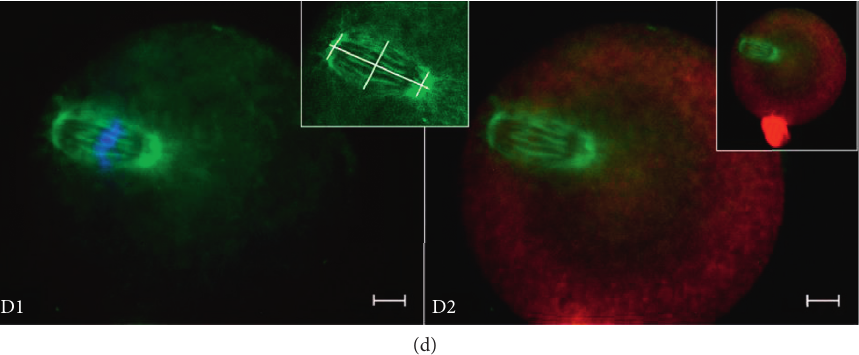
Figure 4: Fluorescent imaging of meiotic spindles (FITC-labelled tubulin), chromatin (stained by Hoechst 3325), and actin structures (Phalloidin-TRITC) in control and CIOA oocytes. Original magnification 1000x. Bar � 10 μ m. (a) An M I control oocyte with a normal spindle (green): A1, combined image with the aligned chromosomes (blue); A2, with the actin cap (red). A1 and A2 are epifluorescent images. The inset is an LSCM image of the same spindle used for measurement (25 μ m long and 15 μ m wide, pole widths 5 μ m and 4 μ m). (b) An M II control oocyte: B1, epifluorescence of a normal M II meiotic spindle in green, with the aligned chromosomes (blue); B2, the spindle and its actin cap adjacent (red), the polar body is seen too, by epifluorescence. The inset shows an LSCM image of the same spindle used for measurement (23 μ m long and 14 μ m wide, pole widths 3 μ m and 6 μ m). (c) An M I CIOA oocyte: C1, the spindle (green) is large (long and wide) with broad poles and disorganized microtubules around the spindle and its poles, and chromosomes (blue) are well aligned, by epifluorescence; C2, the same spindle combined with actin: a large ring (red) is seen instead of actin cap, by epifluorescence. Spindle size calculated using LSCM data: 45 μ m long and 31 μ m wide; poles: 14 μ m and 12 μ m. The inset shows a different M I CIOA spindle of normal length but wide shape and broad poles, with disorganized fibers. LSCM image measurements: 30 μ m long and 19 μ m wide; poles: 9 μ m each. (d) An M II CIOA oocyte. D1, the spindle (green) is large (long and wide), its poles are broad and with disorganized microtubules, and the chromosomes (blue) are well aligned, by epifluorescence. D2, the same spindle with an actin ring (red) instead of the cap (the additional right inset shows the whole oocyte with its polar body at original magnification 400x), by epifluorescence. The LSCM image inset shows the measurements of the spindle (39 μ m long and 21 μ m wide; poles: 10 μ m and 10 μ